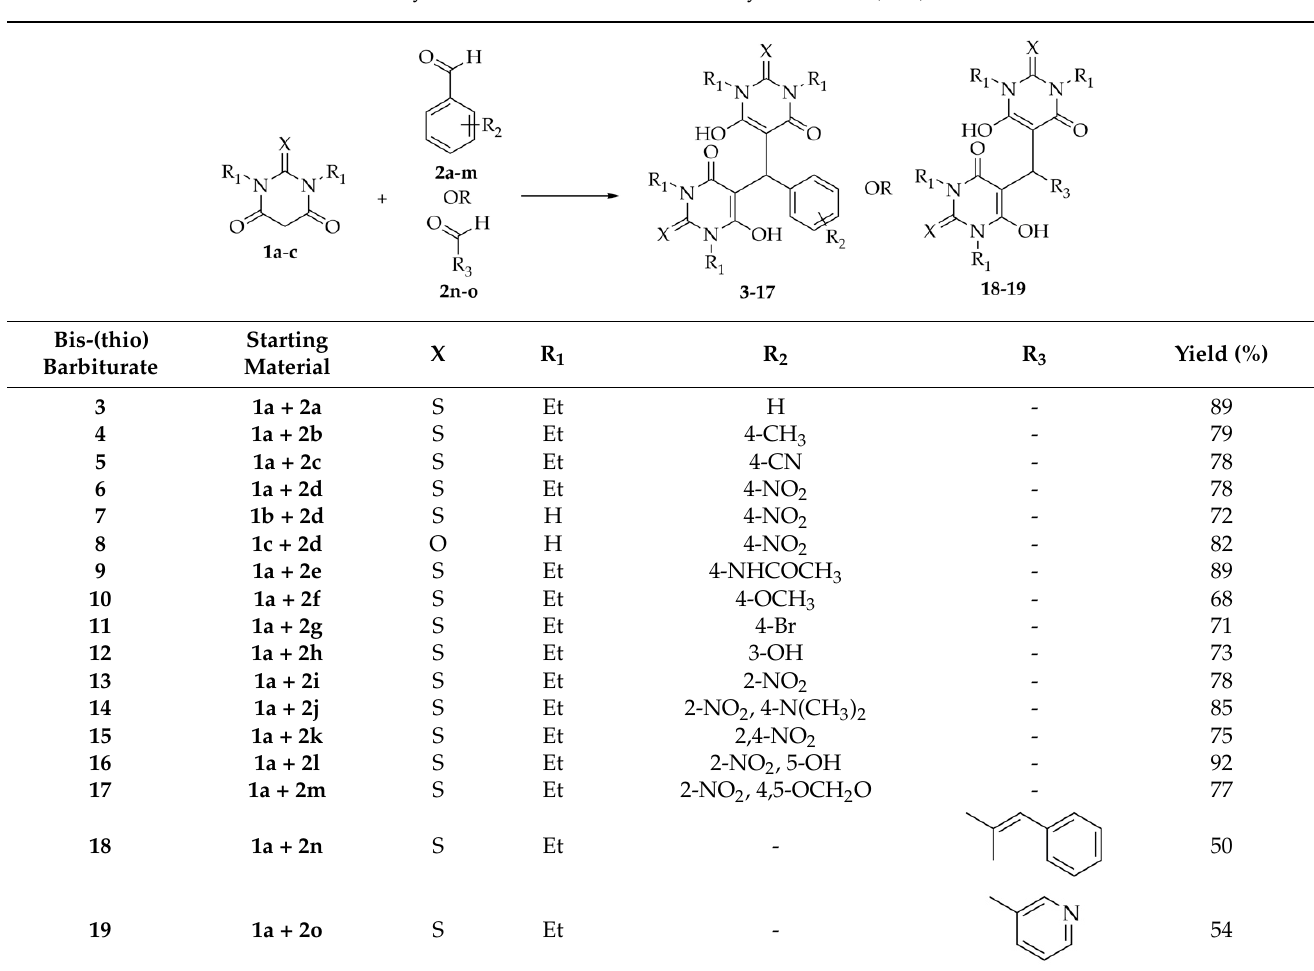
Table 1. Chemical synthesis, structure and reactional yields of bis-(thio)barbiturates 3 – 19 .